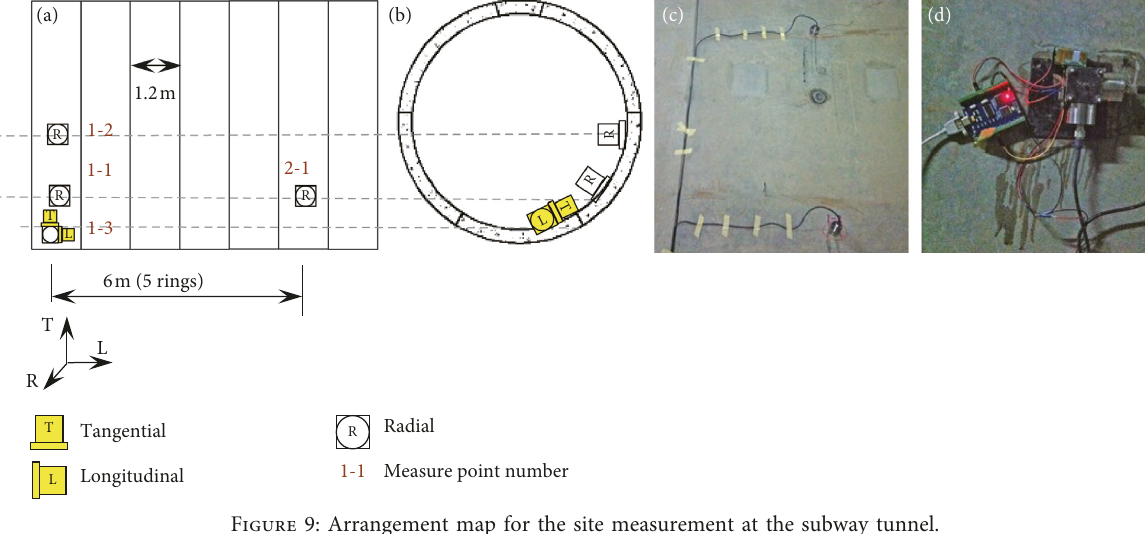
Figure 9: Arrangement map for the site measurement at the subway